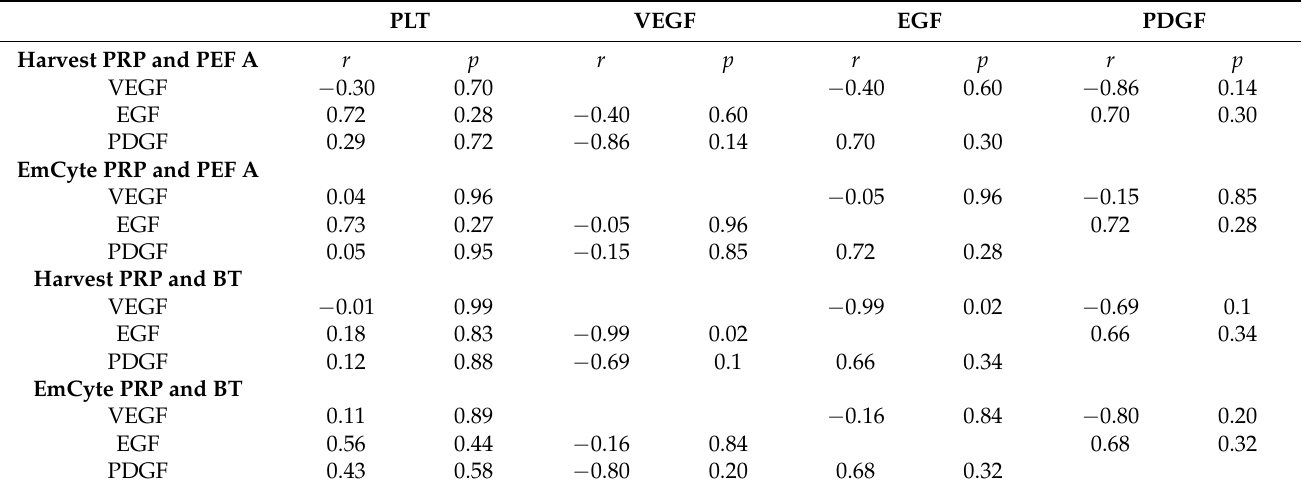
Table 2. Correlation matrix comparing the growth factors with donor platelet concentration and each other for the various treatments with correlation factor r and p values. PLT VEGF EGF